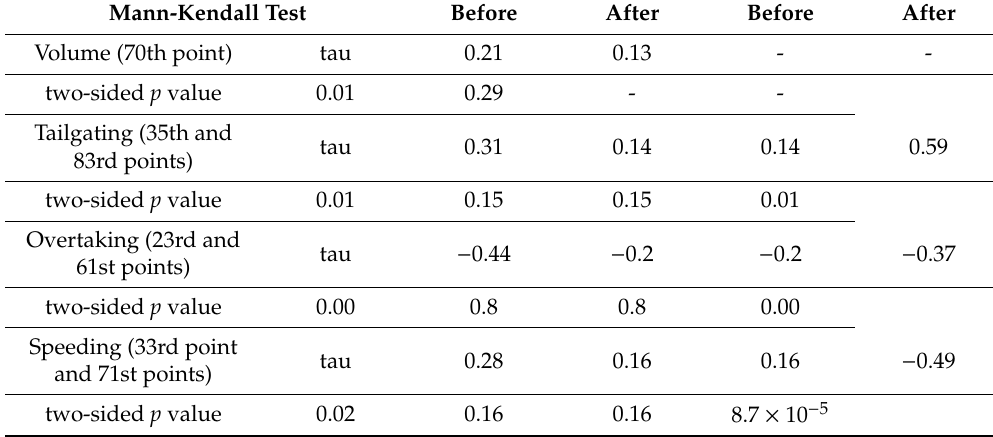
Table 3. Results of Seasonal Mann-Kendall